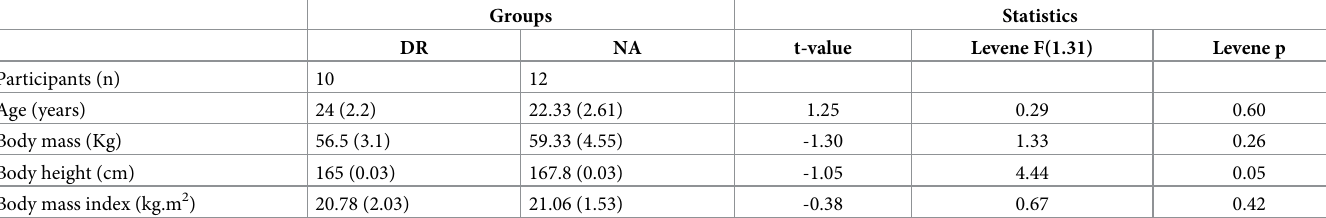
Table 1. Mean characteristics of the DR and NA groups (standard deviation in parentheses) and statistics